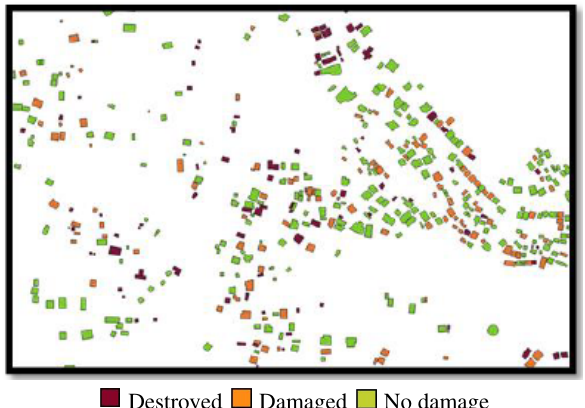
Figure 12. Haiti damages classification ground truth